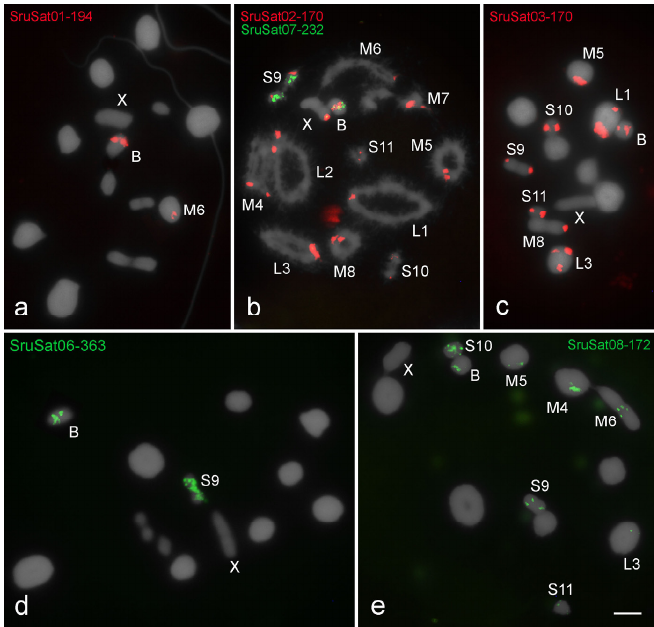
Figure 3. Chromosomal distribution of satDNAs in meiotic cells of S. rubiginosa ( a , c , d , e ) metaphase I and ( b ) diplotene. The distinct satDNAs families are indicated. Chromosomes with signals: X and B chromosomes are identified. Observe that the B chromosome harbors all satDNAs families, three of them shared with some A chromosomes (SruSat02-170, SruSat03-170, and SruSat08-172), and three exclusively shared with pair M6 (SruSat01-194) or pair S9 (SruSat06-363 and SruSat07-232). Bar = 5 µ